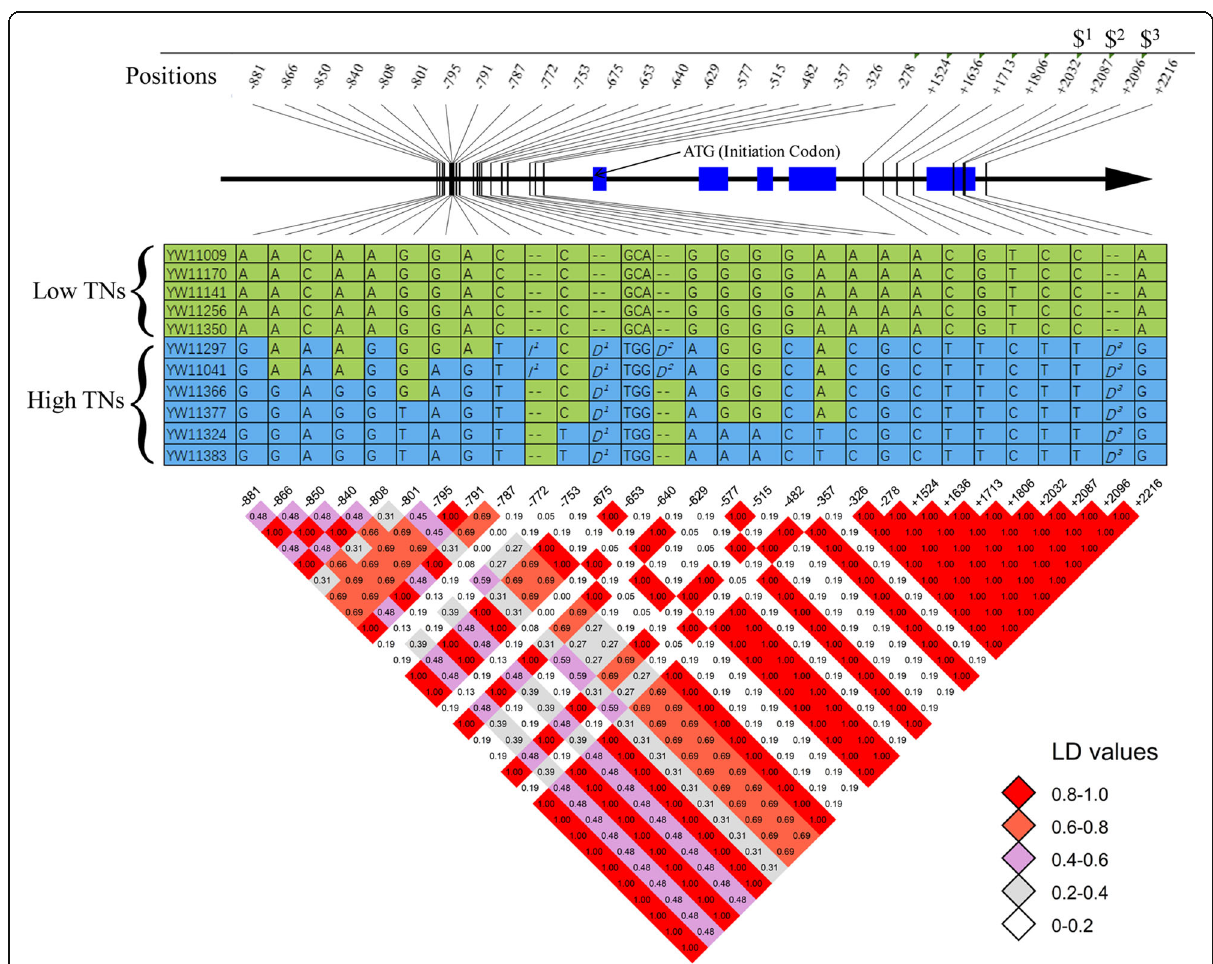
Fig. 5 Sequence analysis of the candidate Os11g15130 gene in the rice accessions with extremely low and high TNs. Tilted number at the top represents the position related to the initiation codon of ‘ ATG ’ ; ‘ - ’ and ‘ + ’ indicate the upstream and downstream of ‘ ATG ’ , respectively. ‘ $ 1 ’ indicates a missense mutation from P to S. ‘ $ 2 ’ indicates a missense mutation from Alanine (A) to Valine (V), while ‘ $ 3 ’ indicates a frameshift mutation caused by the deletion of ‘ AATT ’ . Arrow shows the direction of Os11g15130 ; blue rectangles indicate the gene exon regions. The middle panel is the sequence variations among the extremely low and high TN accessions. The sequence identical regions are not shown in the table due to space limitation. “ ATGC ” indicates the four bases. ‘ -- ’ indicates that the sequences are the same as the reference genome. ‘ I 1 ’ represents an insertion of ‘ TAACT ’ . ‘ D 1 ’ , ‘ D 2 ’ and ‘ D 3 ’ represent deletions of ‘ TGCTAGCTGC ’ , ‘ AC ’ and ‘ AATT ’ , respectively. The bottom panel is the LD-decay of the TN variation in the region. The LD values are included in the blocks with different